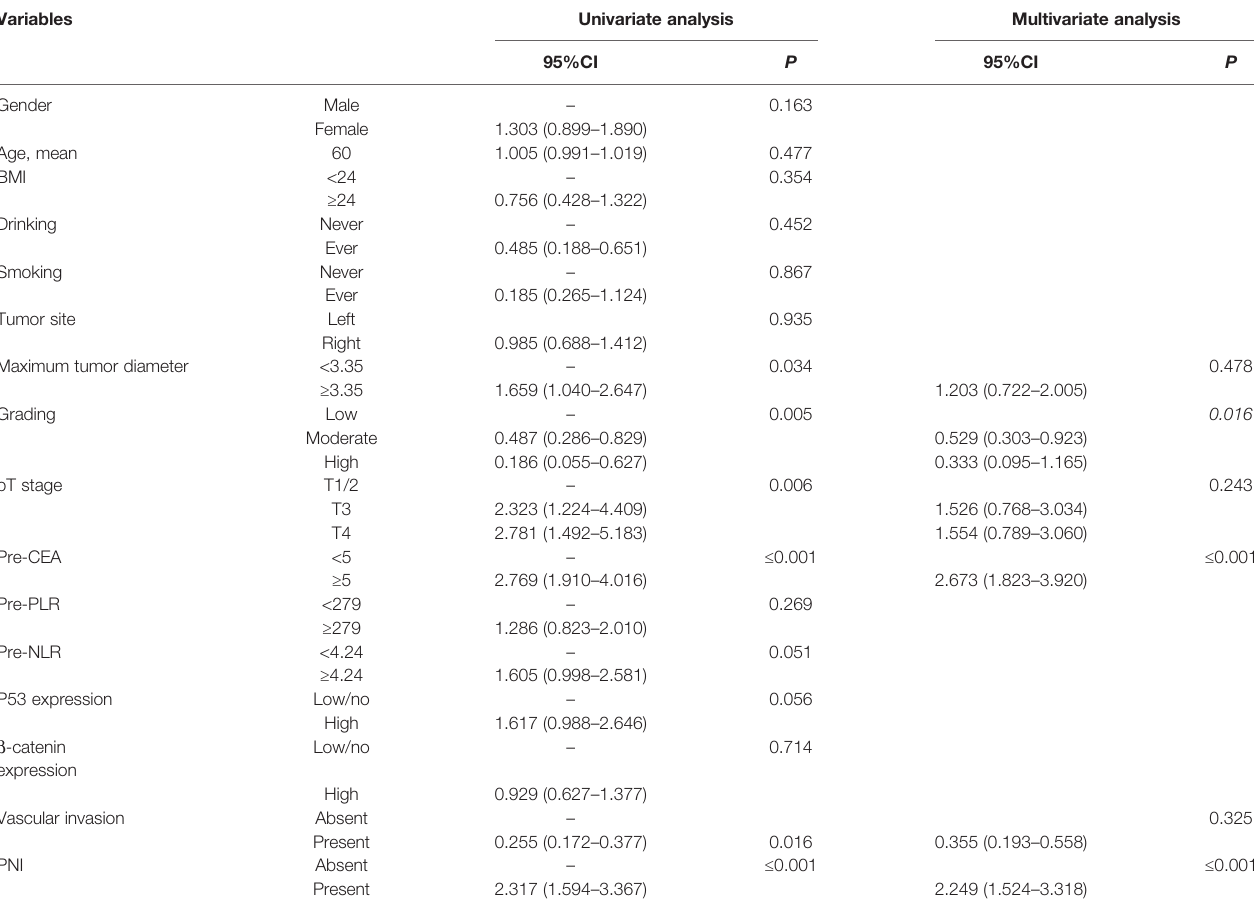
TABLE 3 | Logistic analysis between clinical and pathological parameters and LNM in training set.